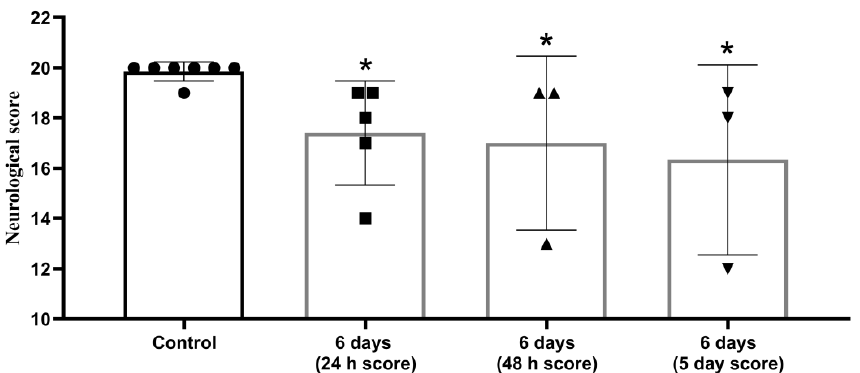
Figure 3. Decrease in neurological status in post stroke period persisted for 5 days after MCAO. The 20-point scale, *—significant difference vs. control ( p ≤ 0.05. Wilcoxon W-criterion). The data are presented as mean with standard deviation.